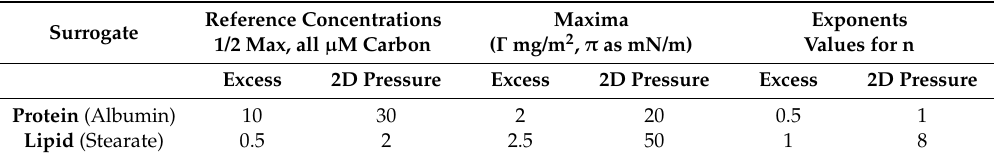
Table A1. Parameter settings drawn from the physical chemical surfactant literature to describe the interfacial behaviors of the proxy compounds. The following are startup information sources: albumin data from Graham and Philips [95], plus stearic acid from Christodoulou and Rosano [94]. CR do not actually quote bulk liquid concentrations, but these have been estimated from Ter Minassian-Saraga [173] and Brzozowska et al. [174]. Values are inserted into the appendix equations to generate the π -A plots shown in Figure A1, π - ε as in the main text tables, and any global maps